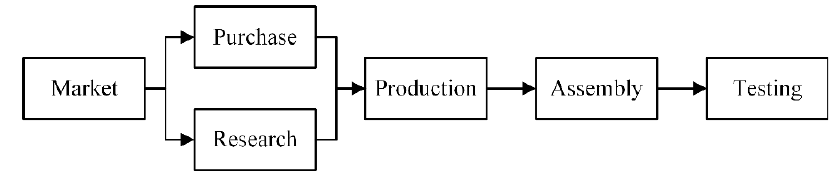
Figure 4. Business process of the case enterprise. Table 2. Business processes and corresponding risk